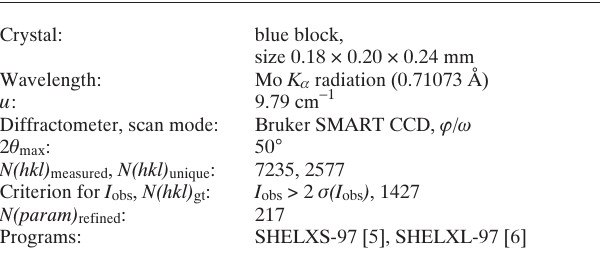
Table 1. Data collection and handling.